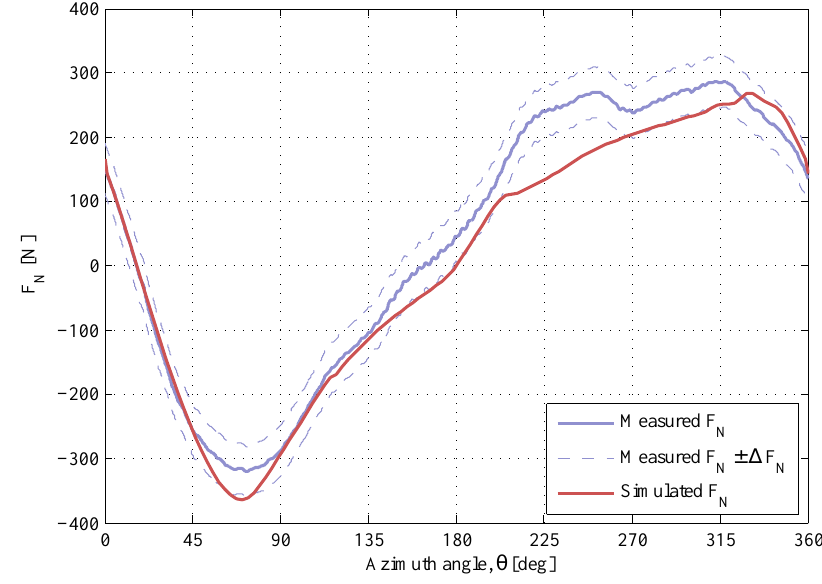
Figure 11. The normal force at λ = 2 . 85 , Ω = 50 . 80 rpm . The air density and the kinematic viscosity are ρ = 1 . 27 kg / m 3 and ν = 1 . 39 · 10 − 5 m 2 / s .